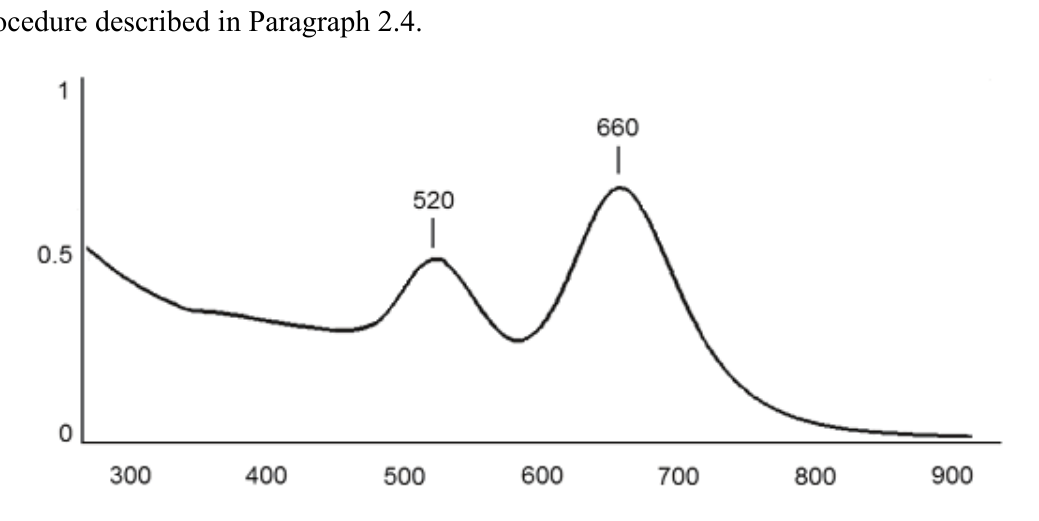
Figure 1. The typical UV-Vis spectrum of GNR suspension obtained according to procedure described in Paragraph